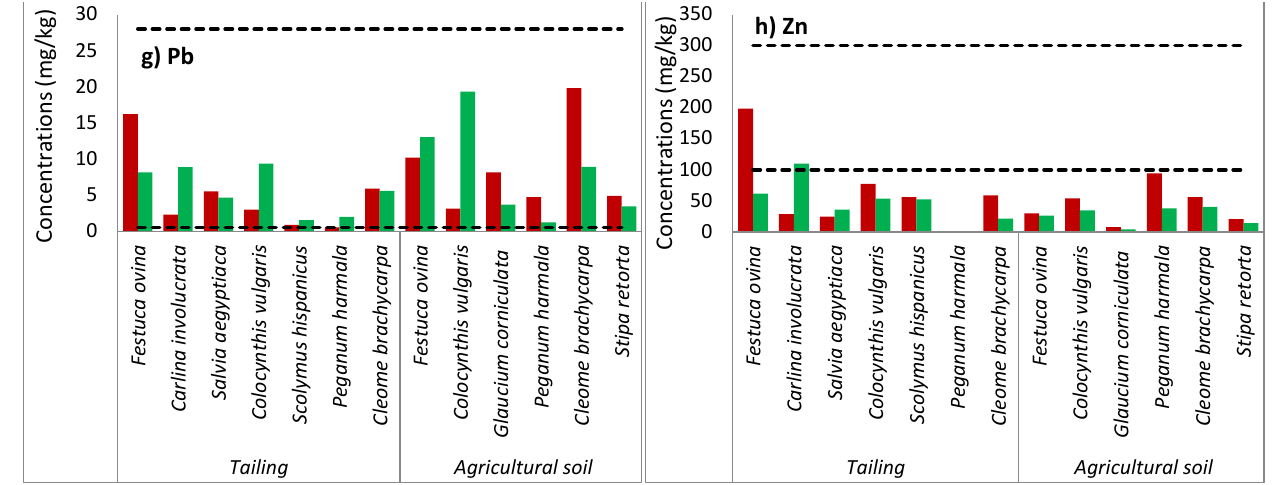
Figure 3. Concentration of ( a ) Cr, ( b ) As, ( c ) Cd, ( d ) Co, € Cu, ( f ) Ni, ( g ) Pb, and ( h ) Zn in shoots and roots (mg/kg dry weight) of species growing in tailings and in agricultural soil at Kettara abandoned mine.